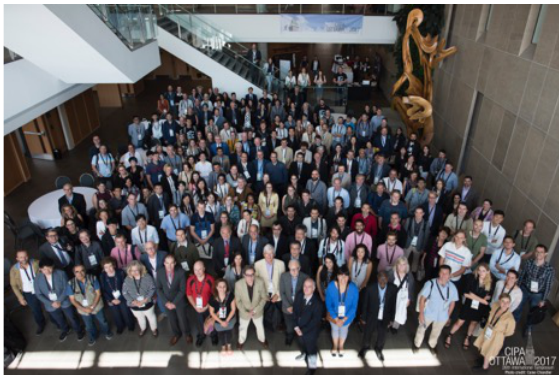
Figure 9: CIPA 2017 symposia attendees, Christian